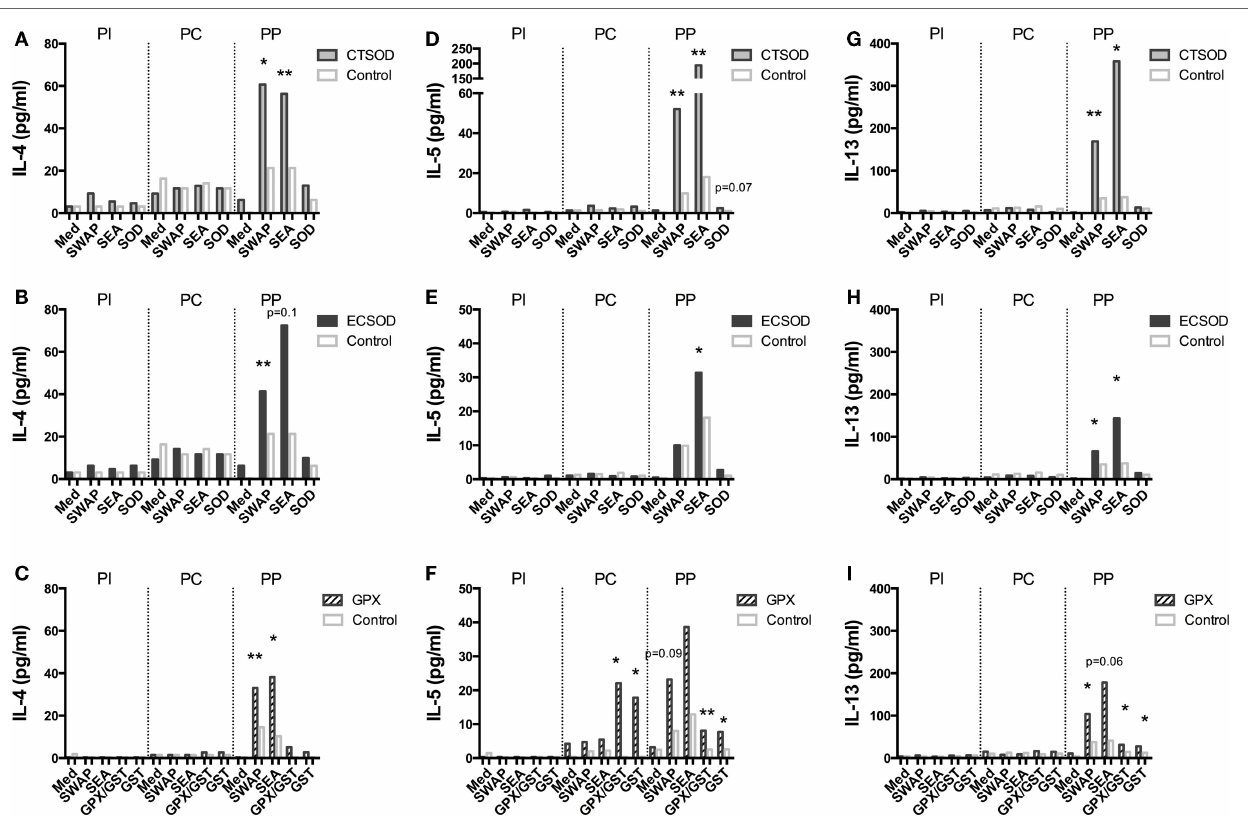
expressed as median of cytokine secretion in five individual supernatants in relation to the Control baboons. Non-parametric (Kruskal–Wallis, Mann– Whitney) tests were applied. Values were considered statistically significant when p < 0.05, and assigned * p = 0.01–0.05; ** p = 0.001–0.01; and *** p = <